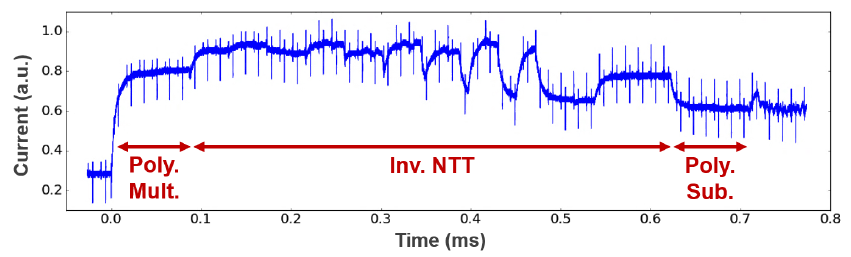
Figure 19: Power trace for the NewHope-1024- CPA-PKE.Decrypt algorithm, measured from our test chip operating at 1.1 V and 12